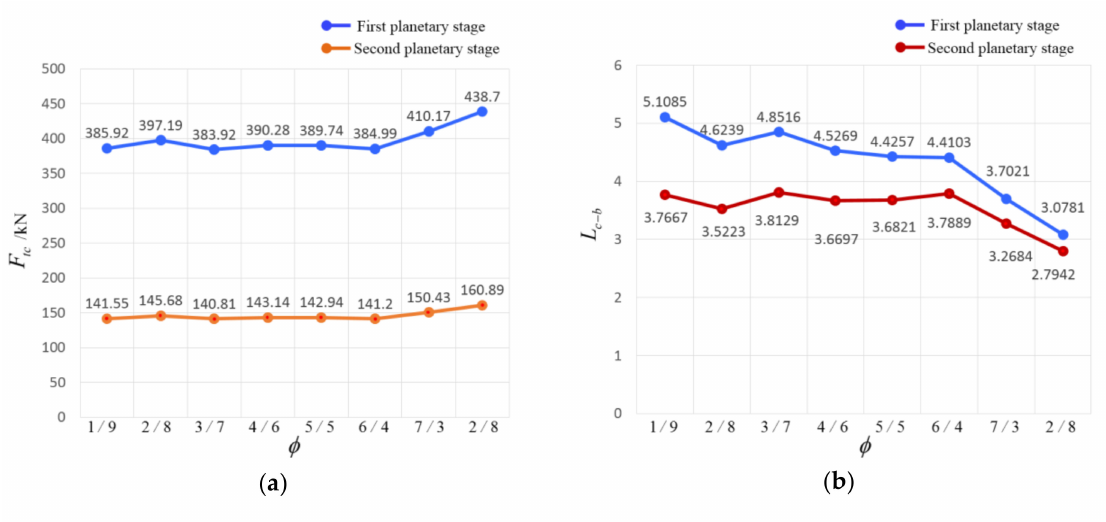
Figure 11. Relationship between power ratio and force and life of gearbox of DRWT: ( a ) the tangential force on the pitch circle of the planet gear; ( b ) bearing life of the planet